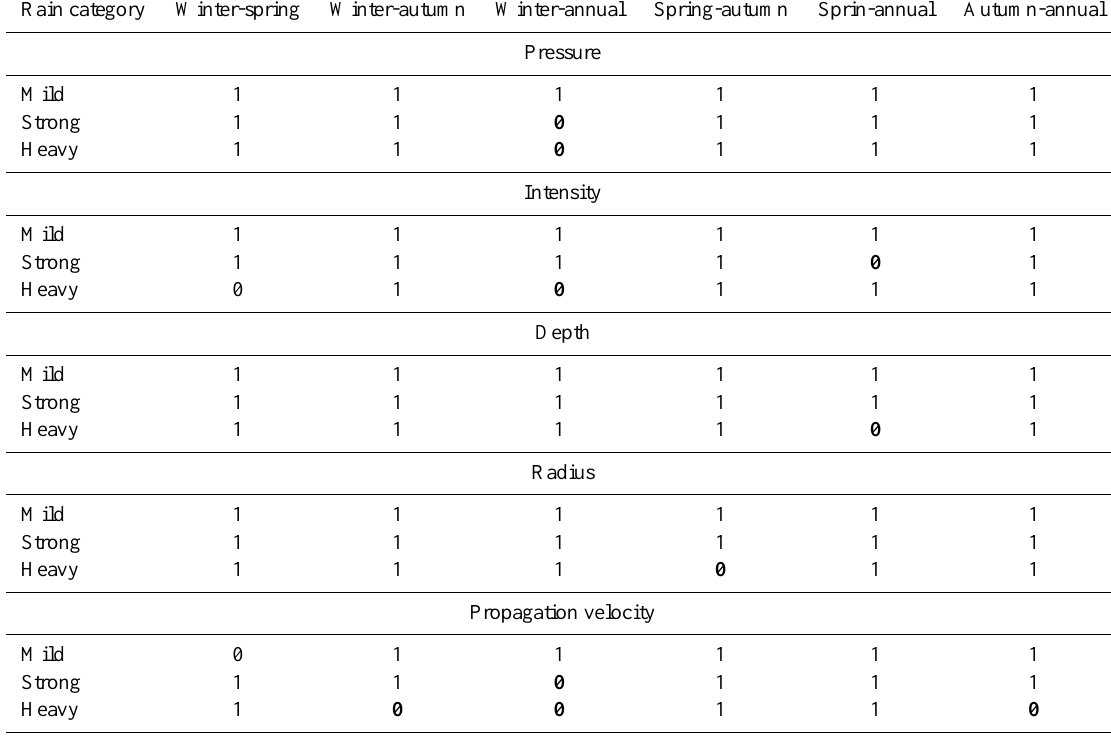
Table 4. Statistical significance results for the characteristics of “affecting” cyclones concerning the different seasons. The statistical signif- icant differences at 5% significant level are denoted by 1. The zero values denoted in bold font are those not significant in neither 1, 5 nor 10% significant level and zero values which were not noted are significant at 10% significant